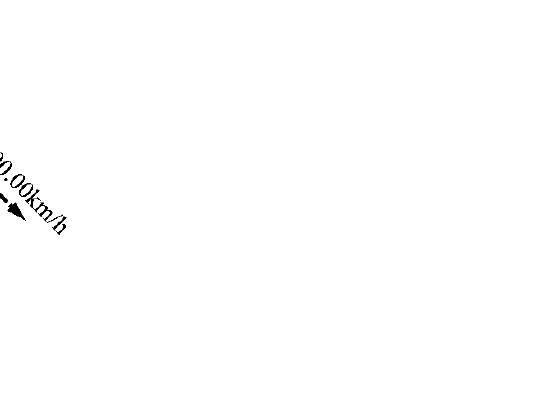
Figure 1. An orbiting object around Earth (Sputnik), with its velocity and applied forces. The procedures for real microgravity experimentation are expensive and scarcely available.